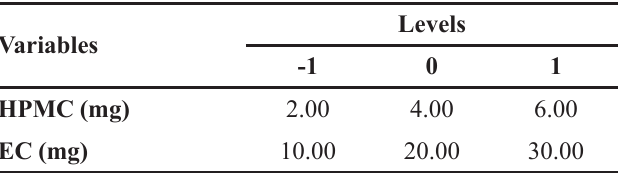
TABLE II - HPMC and EC variables and levels (-1, 0 and 1) used